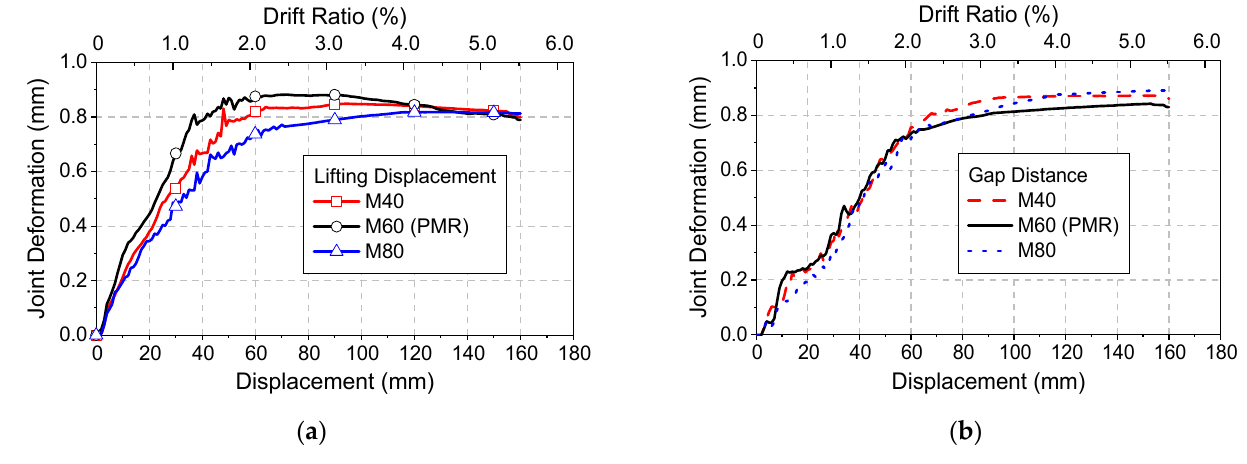
Figure 31. Joint deformation curves with different mortar grades: ( a ) Lifting displacement; ( b ) Gap distance.